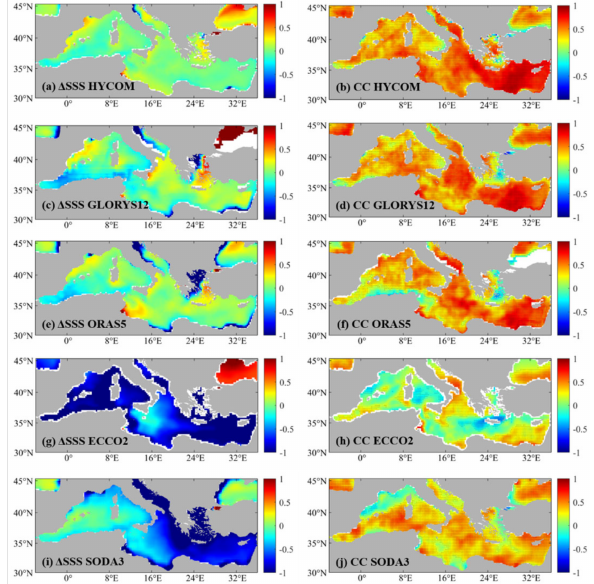
Figure 4. Horizontal distribution of mean ∆ SSS (left) and RMSD (right) values with respect to CMEMS L4 objective analyzed SSS. From top to bottom: HYCOM, GLORYS12, ORAS5, ECCO2 and SODA3. The unit of ∆ SSS is in PSU and the CC values are